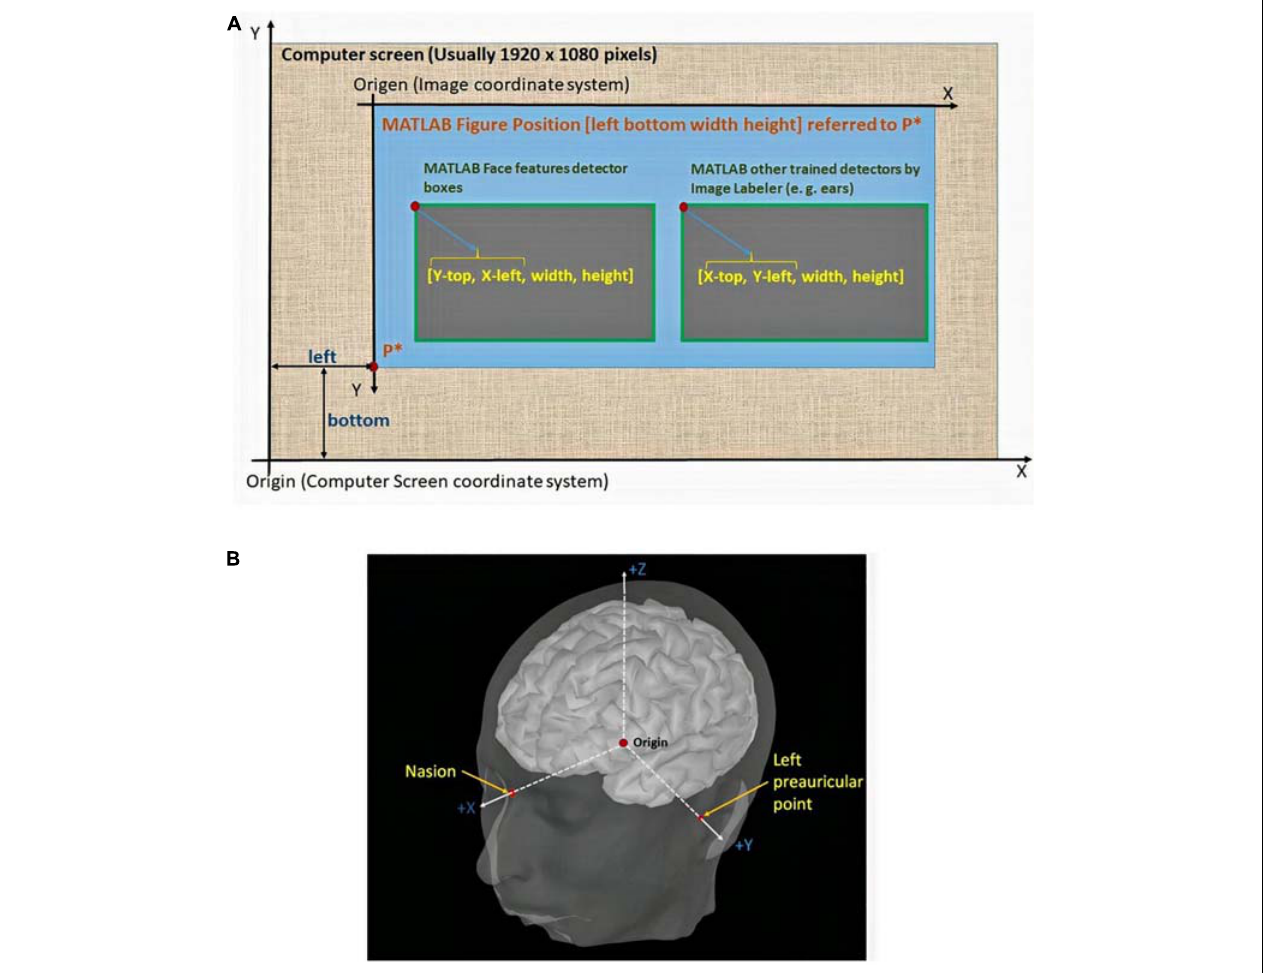
FIGURE 8 | (A) Differences among the intrinsic coordinate system of the pixels on the screen, the MATLAB figure positions, and the box structures returned by the detectors. (B) Subject coordinate system